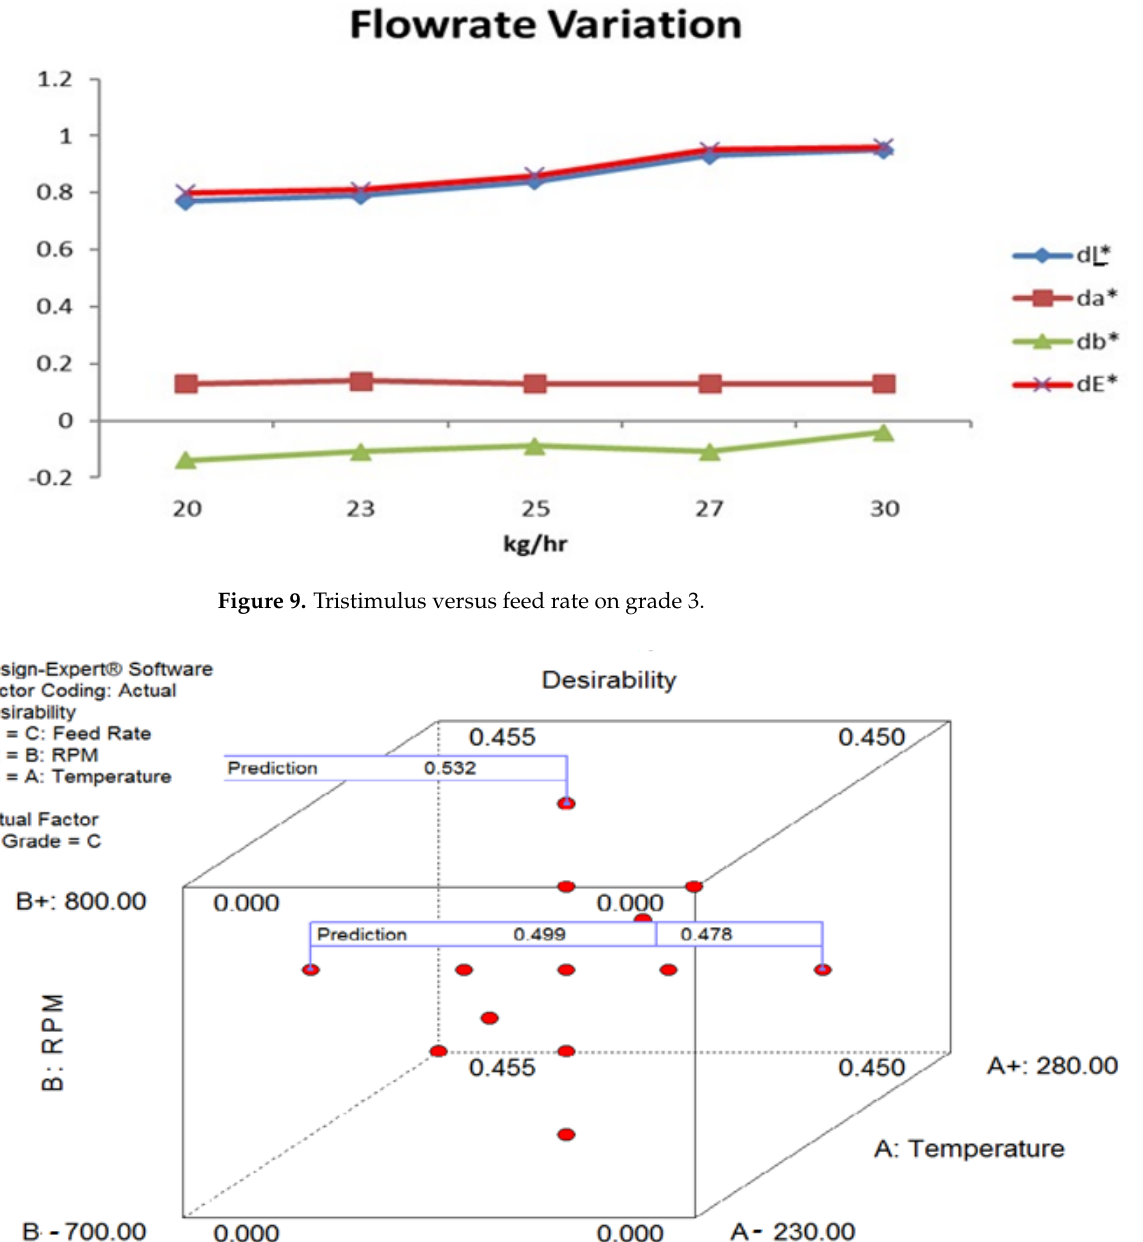
Figure 8. Effect of feed rate on b*.